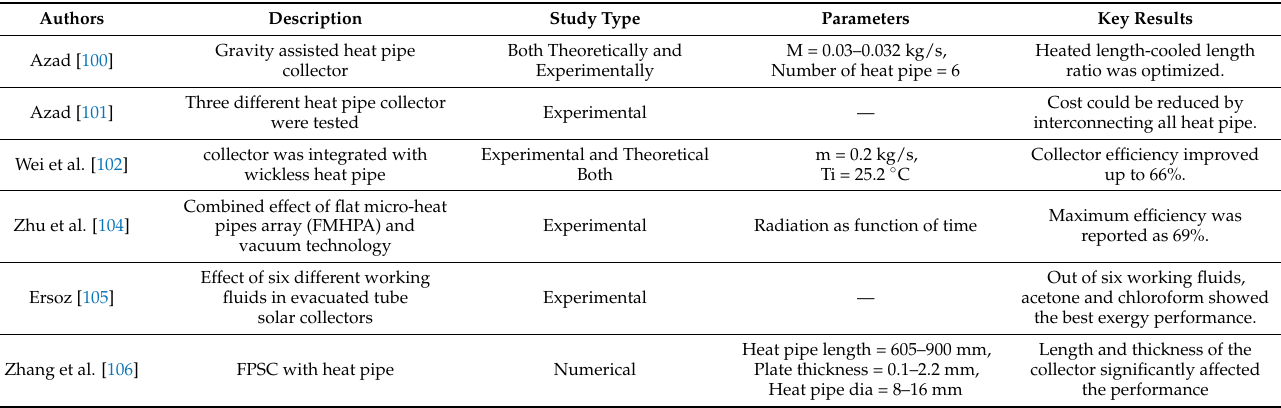
Table 5. Selective study of the heat pipe and mini/micro channel used in the